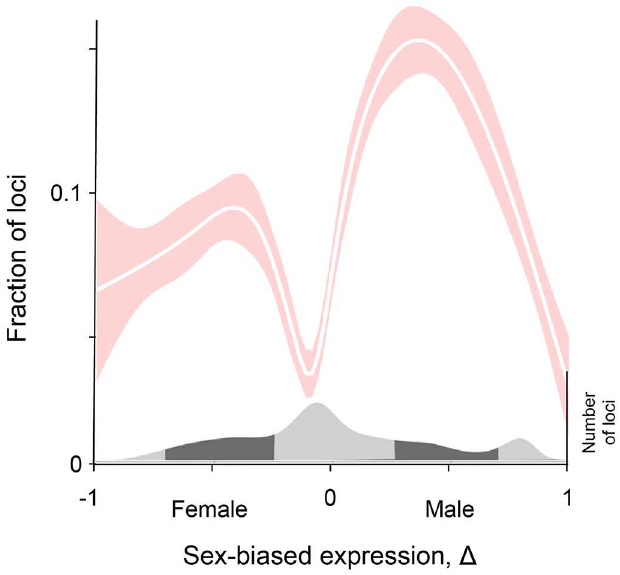
Fig 2. The Twin Peaks patternin flies. The relationbetweenthe fractionof genes under sexually- antagonistic selectionand Δ is shown by the best-fitcubic spline (whiteline),and the 95% confidence interval is shown by the shaded areas. The distribution of gene numbersis shown at the bottomof the